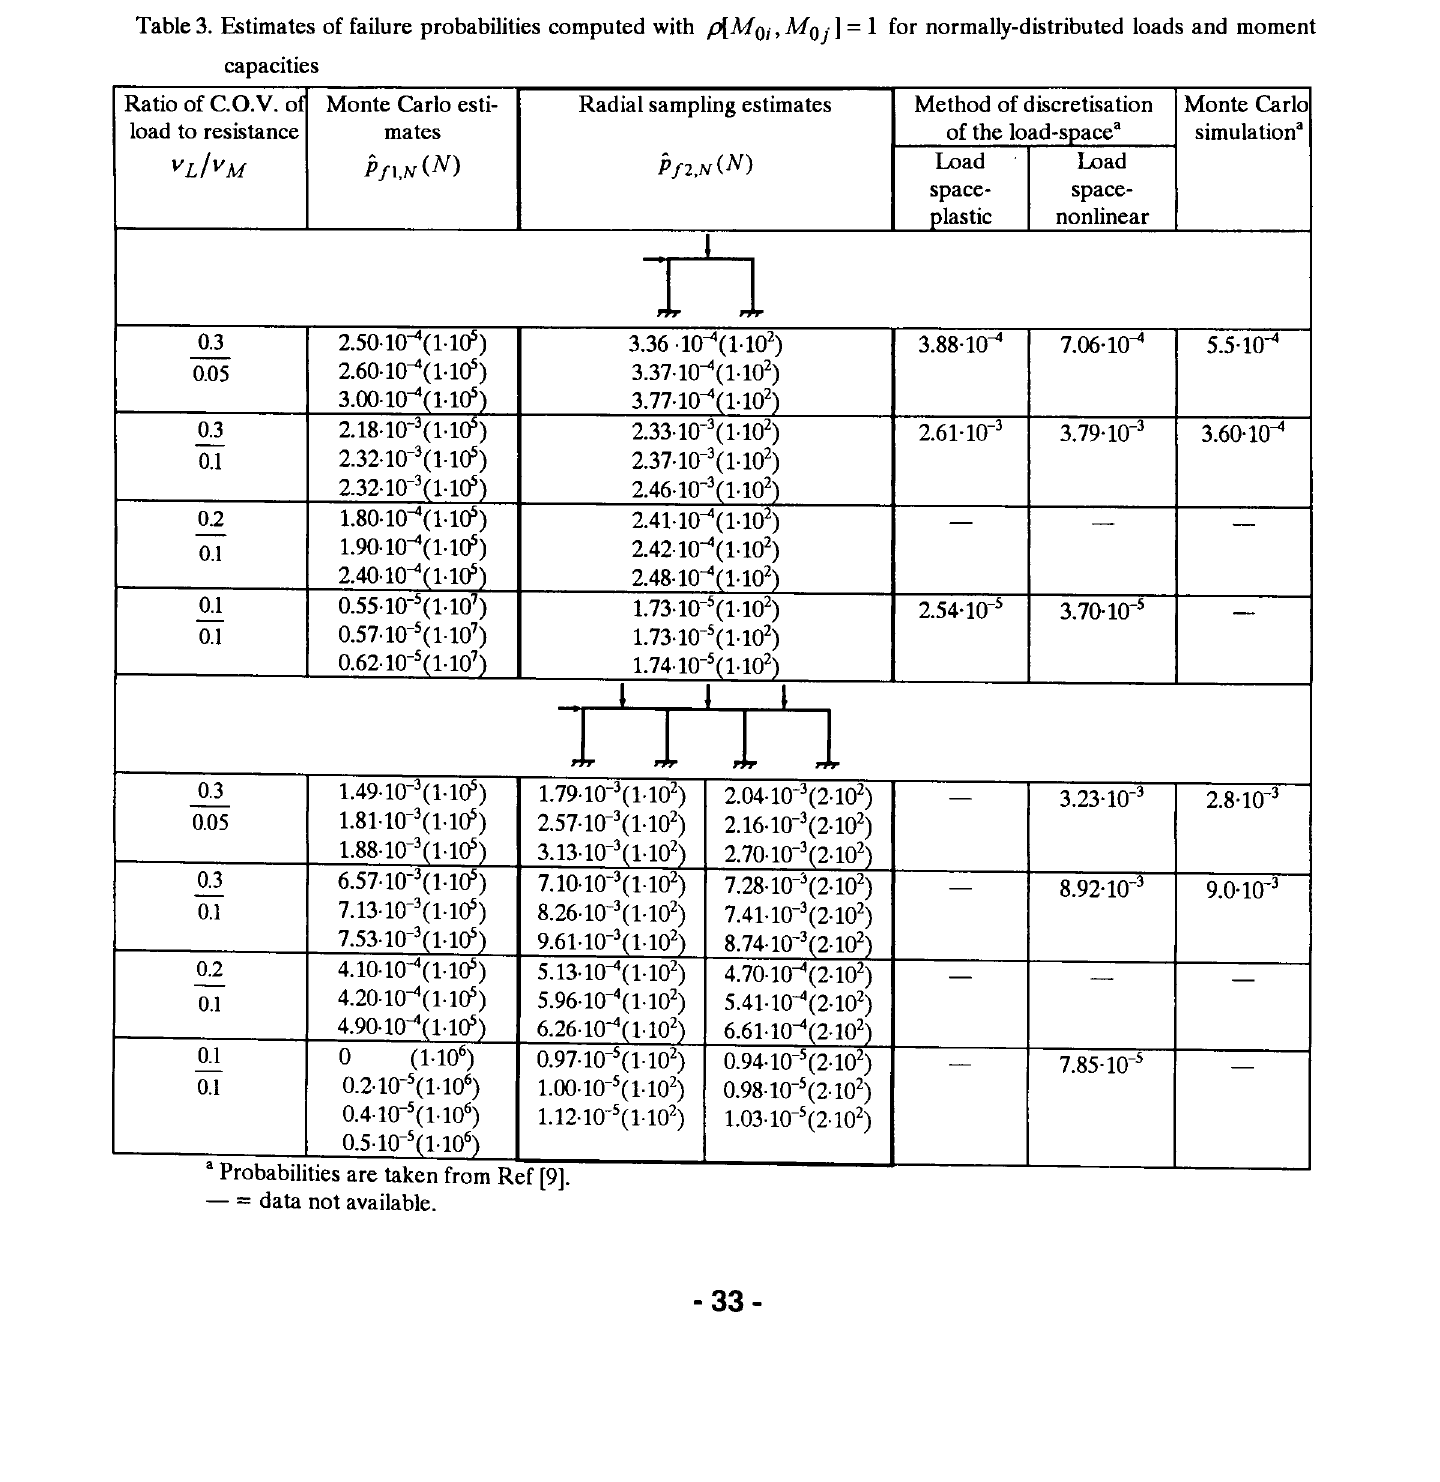
) = 1 for normally-distributed loads and moment 1